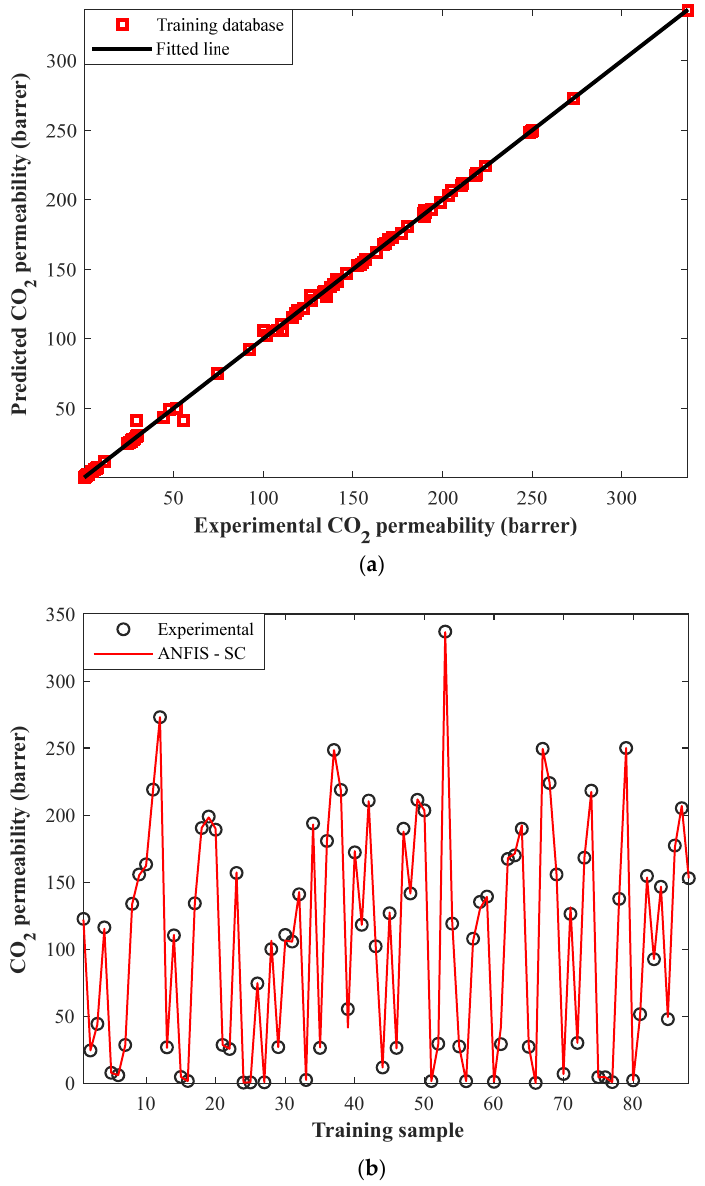
Figure 3. ( a ) Cross-plot of ANFIS-SC predictions versus experimental CO 2 permeabilities in the training step. ( b ) Experimental CO 2 permeabilities and their related ANFIS–SC predictions in the training step.